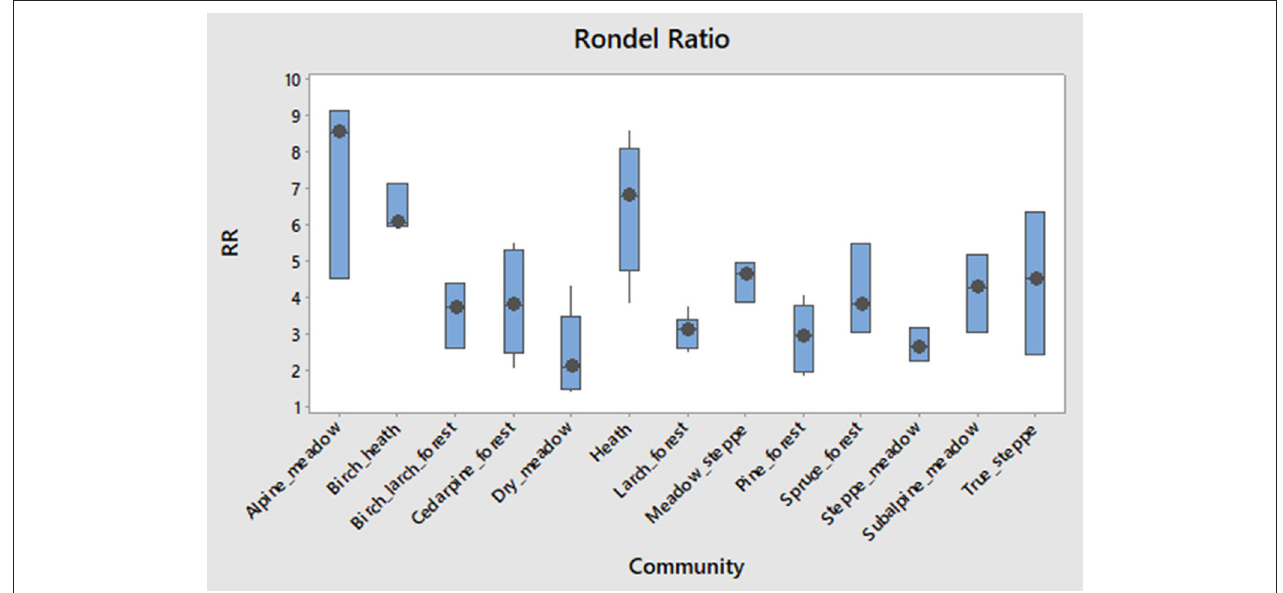
FIGURE 10 | Boxplots showing frequency of rondel ratio RR. The ratio is explained in